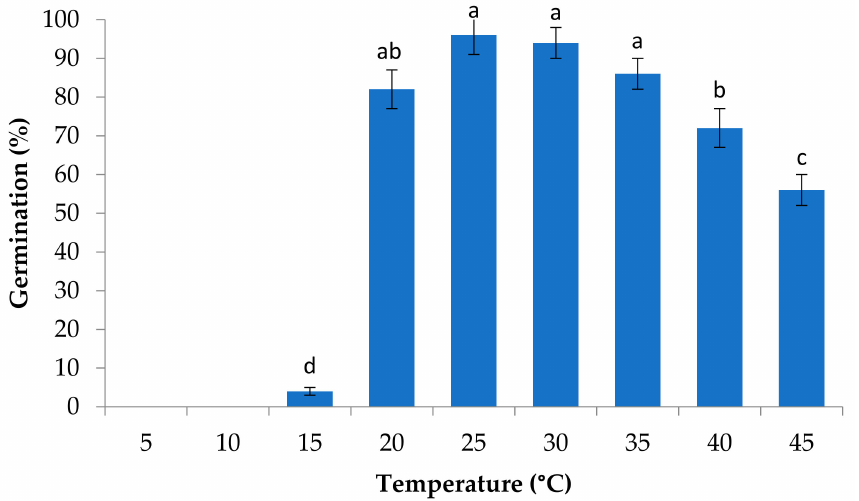
Figure 1. Germination percentages for each temperature treatment. Error bars show standard deviation. Means that share a letter are not significantly different ( p ≤